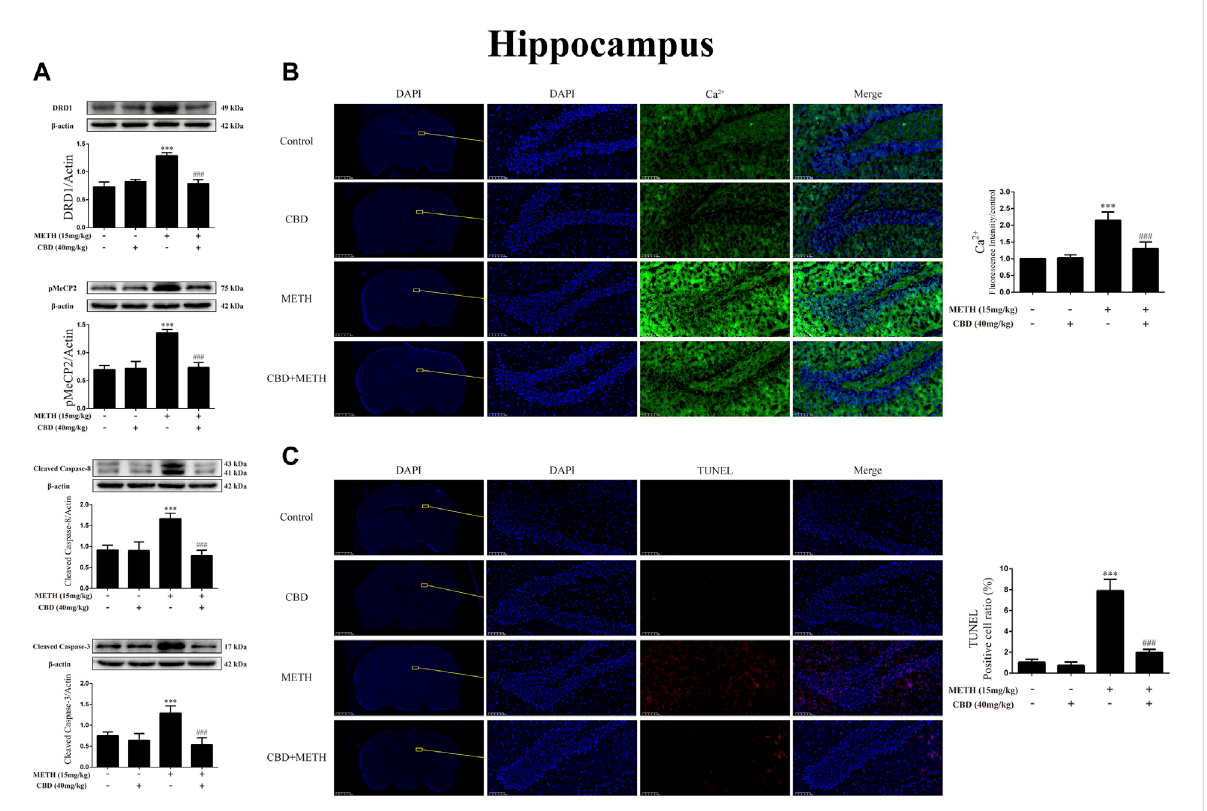
FIGURE 11 Protein, intracellular Ca 2+ , and apoptosis levels in hippocampus of rats repeatedly exposed to CBD and/or METH. (A) Levels of DRD1, pMeCP2, and apoptosis-related proteins in hippocampus. (B) Intracellular Ca 2+ level in hippocampus. (C) Apoptosis level in hippocampus. *** p < 0.001 compared with control group, ### p < 0.001 compared with METH group; Tukey HSD post-hoc comparison after signi fi cant